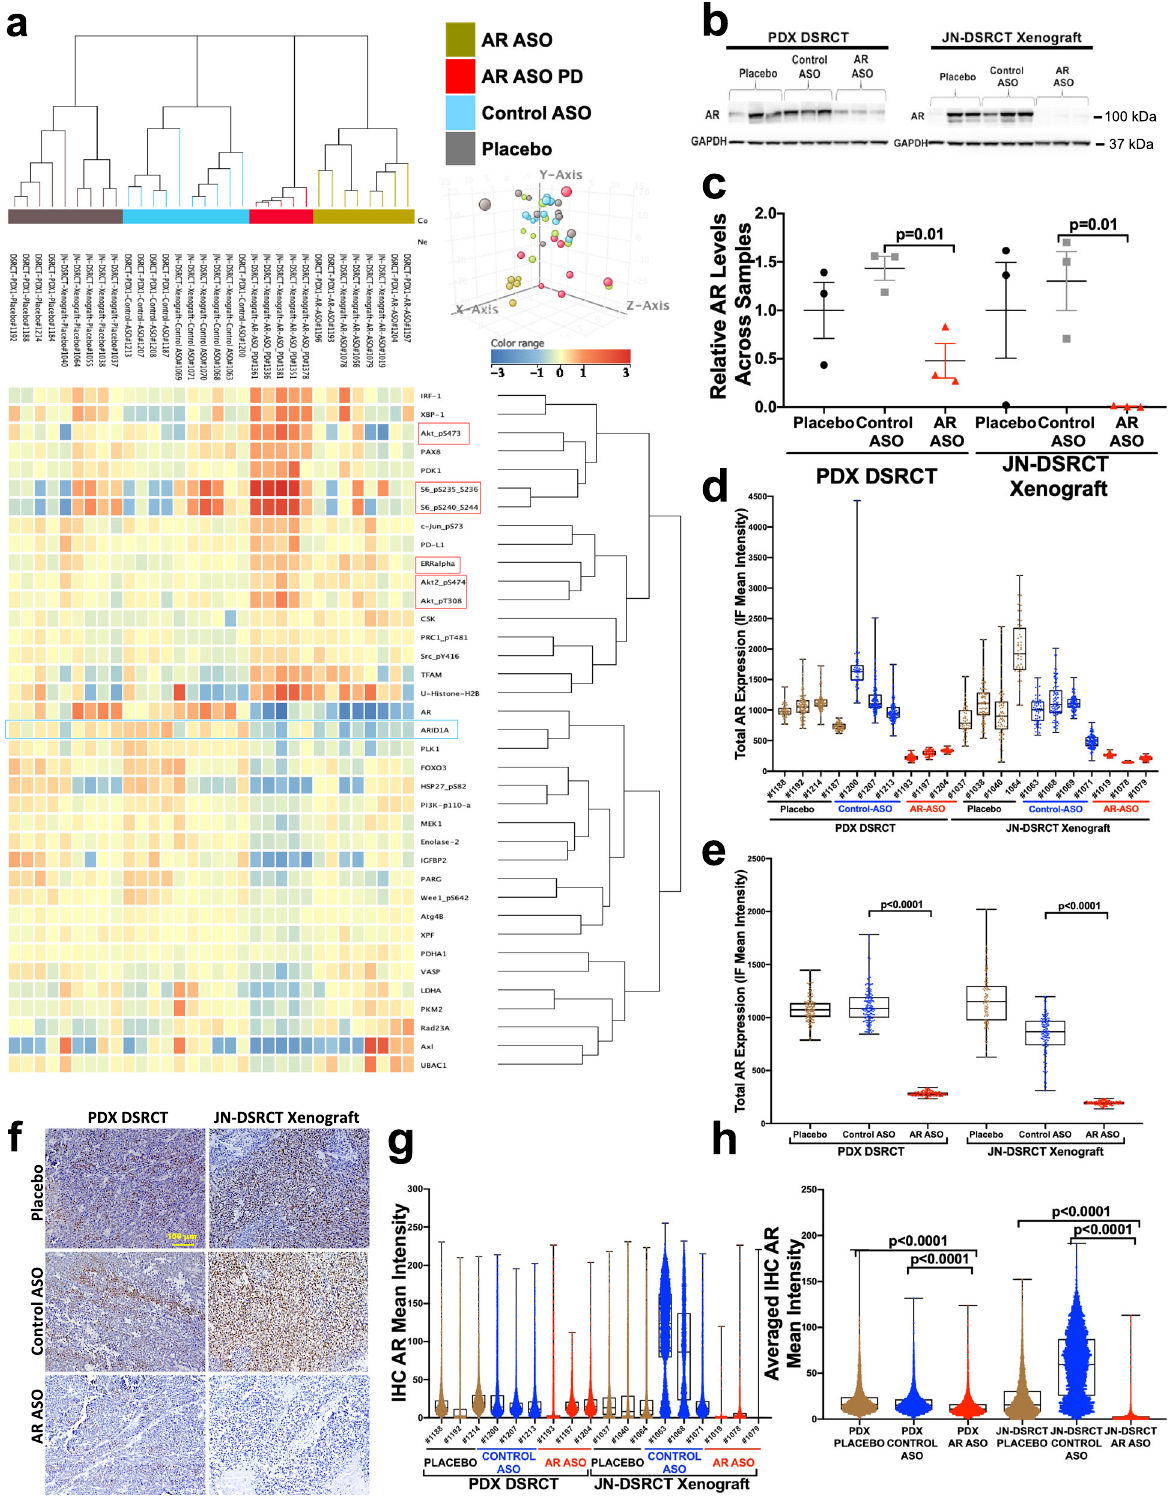
AR directly regulates important oncogenic regulators in DSRCT . To model the AR transcriptional program in a human JN-DSRCT cell line, we determined the genome-wide AR binding pro fi les using ChIP-Seq experiments in unstimulated or DHT- stimulated JN-DSRCT cells treated with control ASO or AR-ASO. As expected, DHT treatment enhanced AR binding to the chro- matin as assessed by the average intensity plot on all signi fi cant